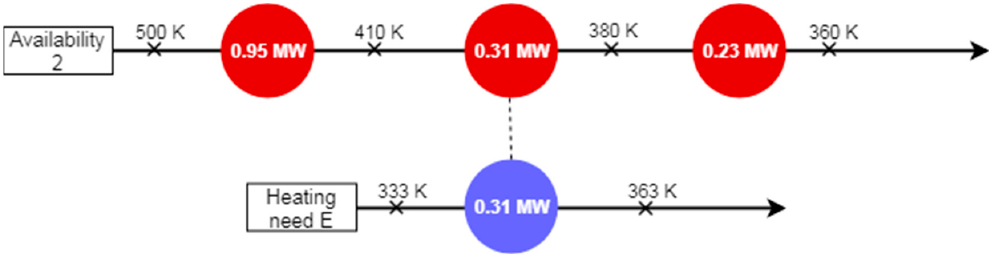
Figure 19. Compressors' C1 inlet air preheating assessment.